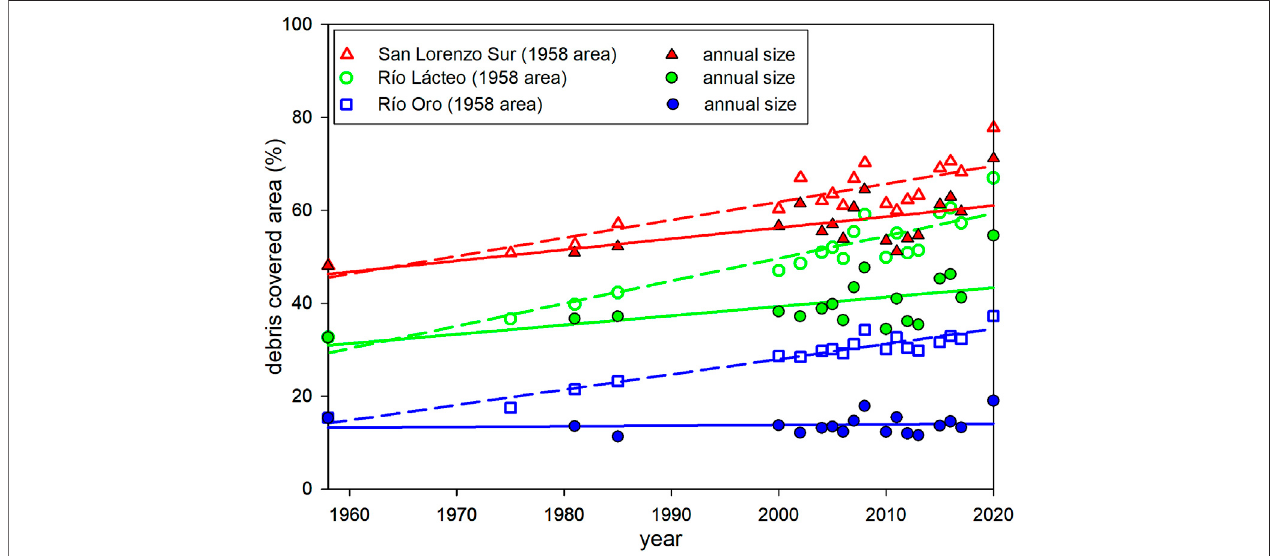
FIGURE 3 | Scatter plot showing the debris cover increase through time. The color-void (and regression dashed line) symbols show the percentual increase of debris-covered ice area considering the initial 1958 glacier area, and the color- fi lled symbols (regression solid lines) depicts the increase taking the actual glacier size for each survey year into account.